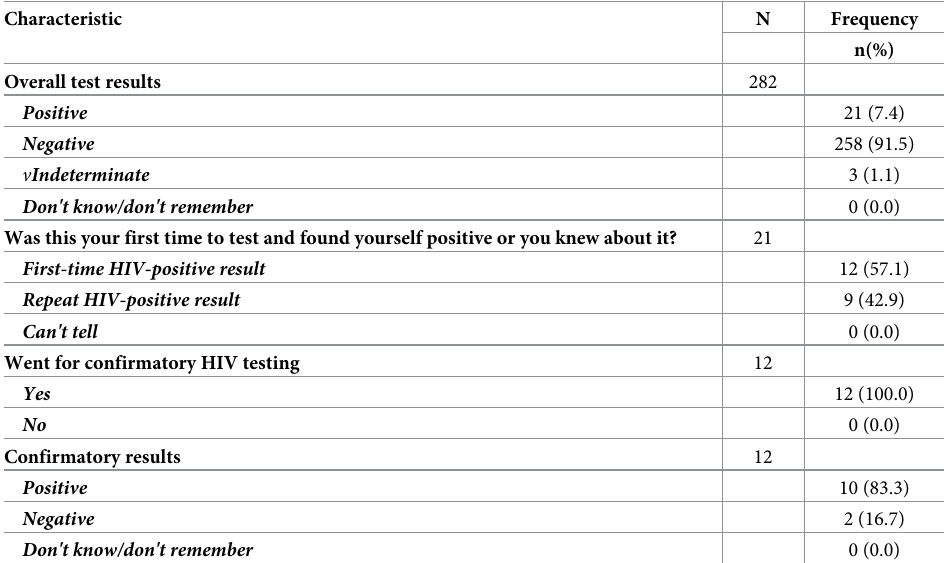
Table 5. Preliminary intervention